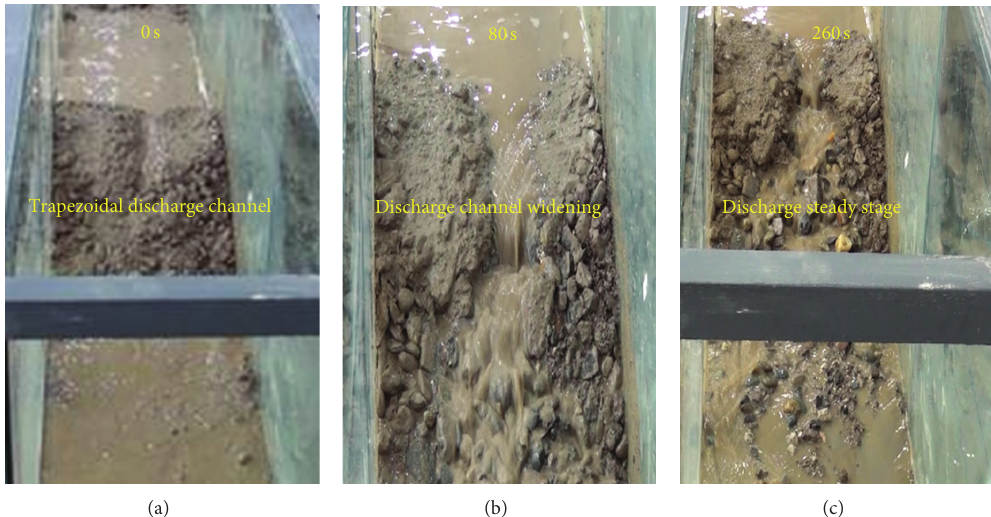
Figure 15: The process of dam break of a landslide dam with a trapezoidal discharge channel at different time intervals: (a) 0s, (b) 80 s, and (c) 260 s.